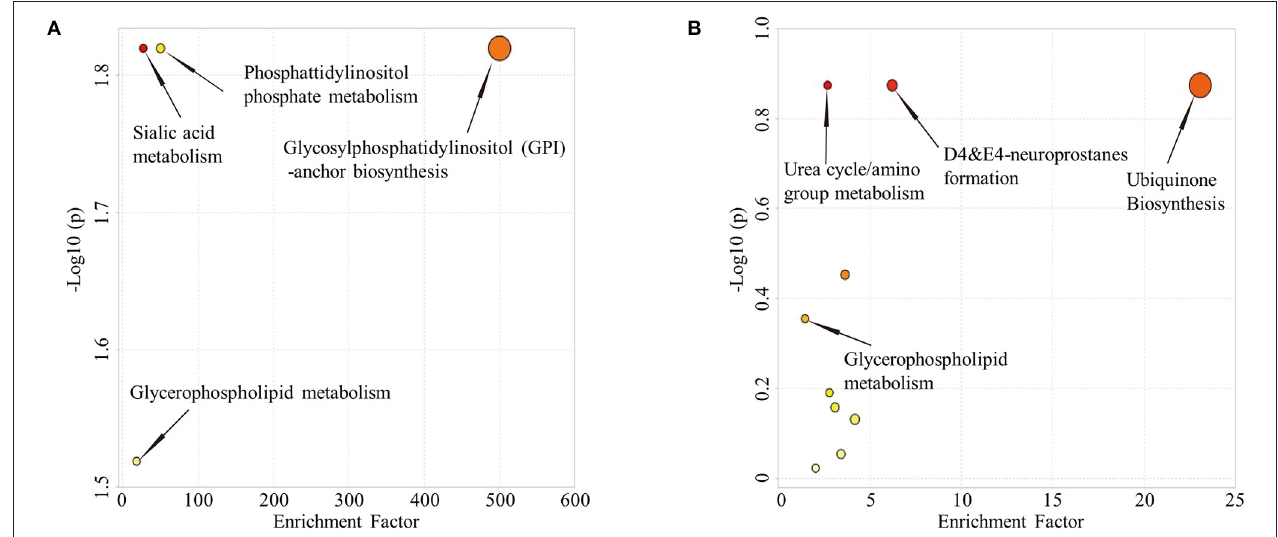
FIGURE 4 | (A) Metabolic pathways from HC to aMCI. (B) Metabolic pathways from aMCI to AD.